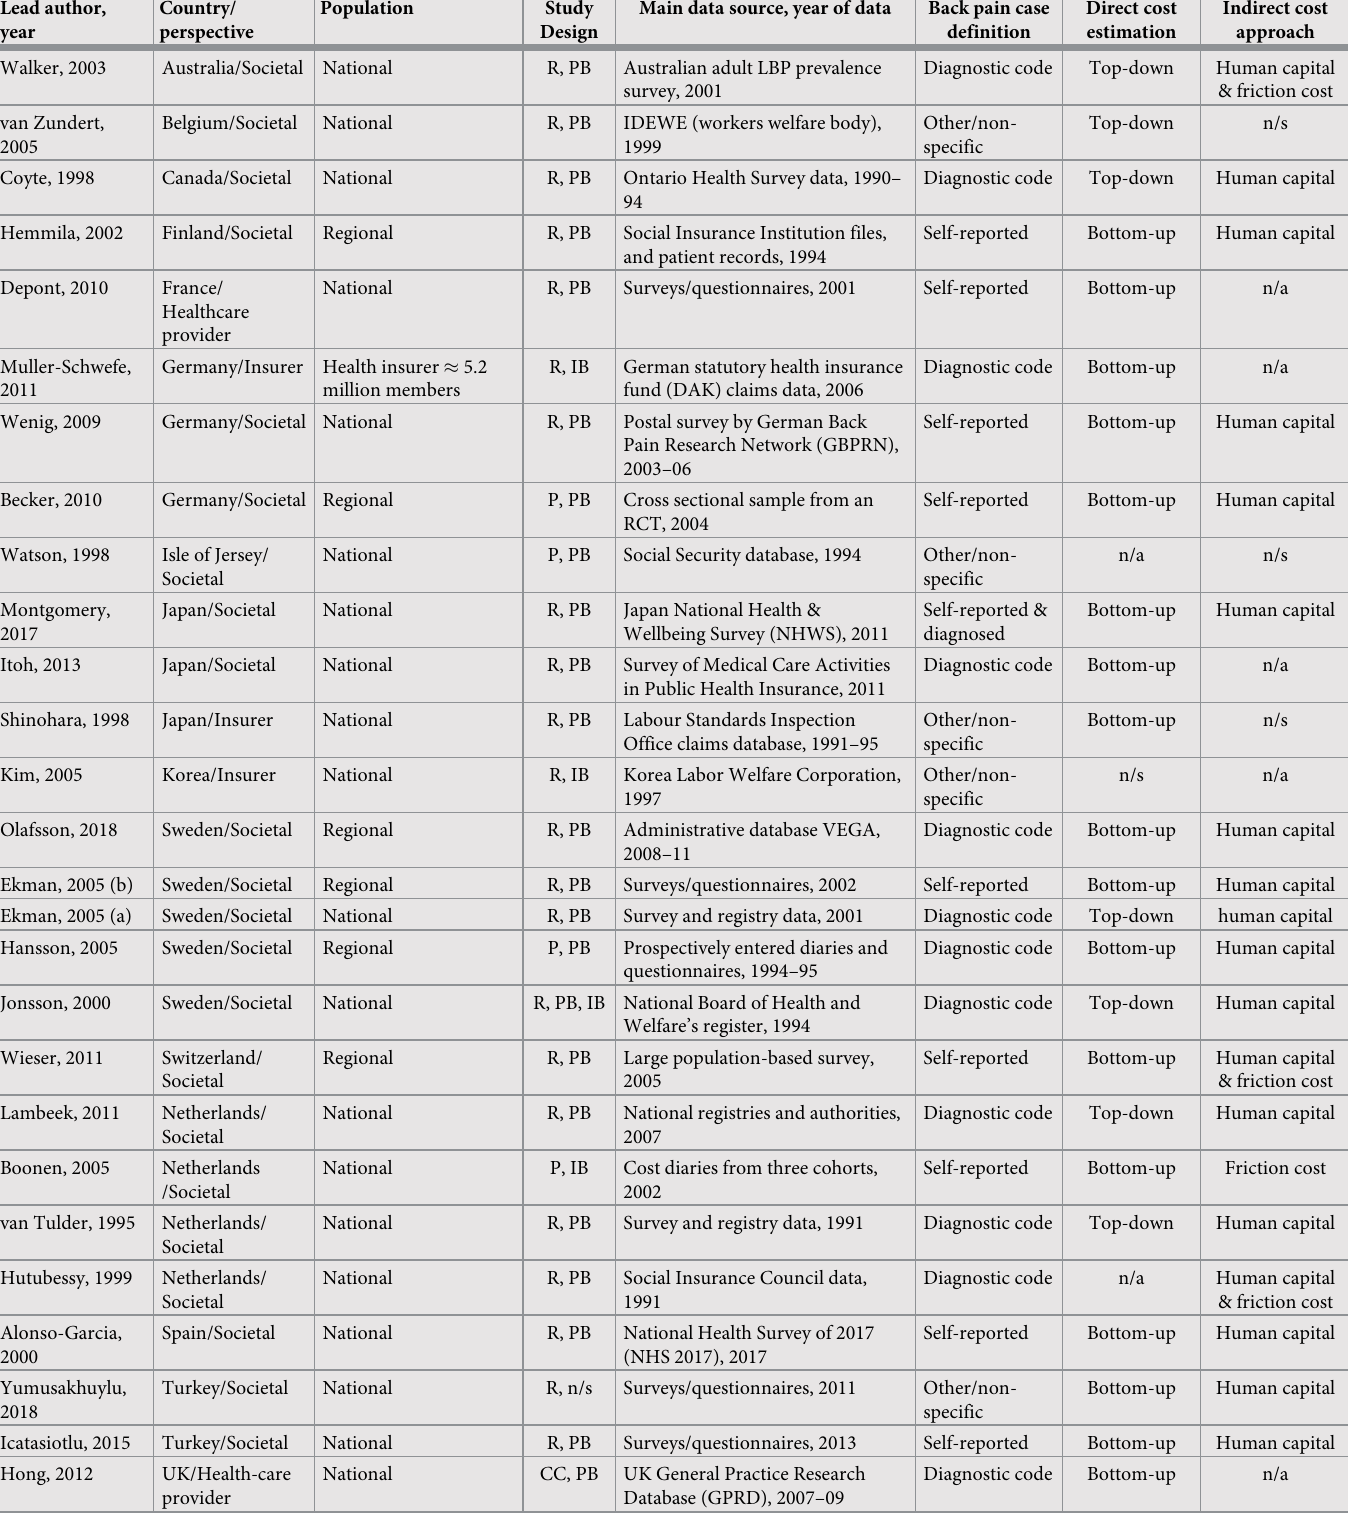
Table 2. Summary of the main characteristics of the included